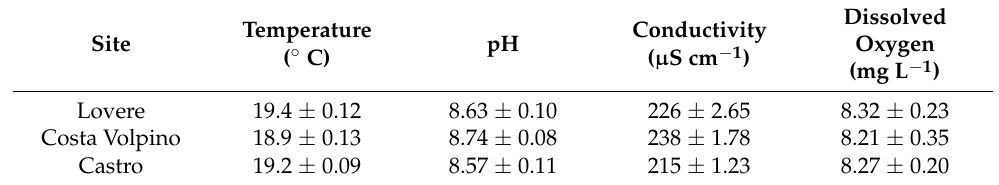
Table 1. Physicochemical parameters of water (mean ± [SD] standard deviation) at the three sampling